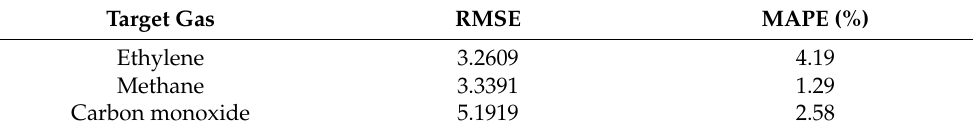
Table 13. Prediction results for three gas concentrations with the full-sample selection strategy.